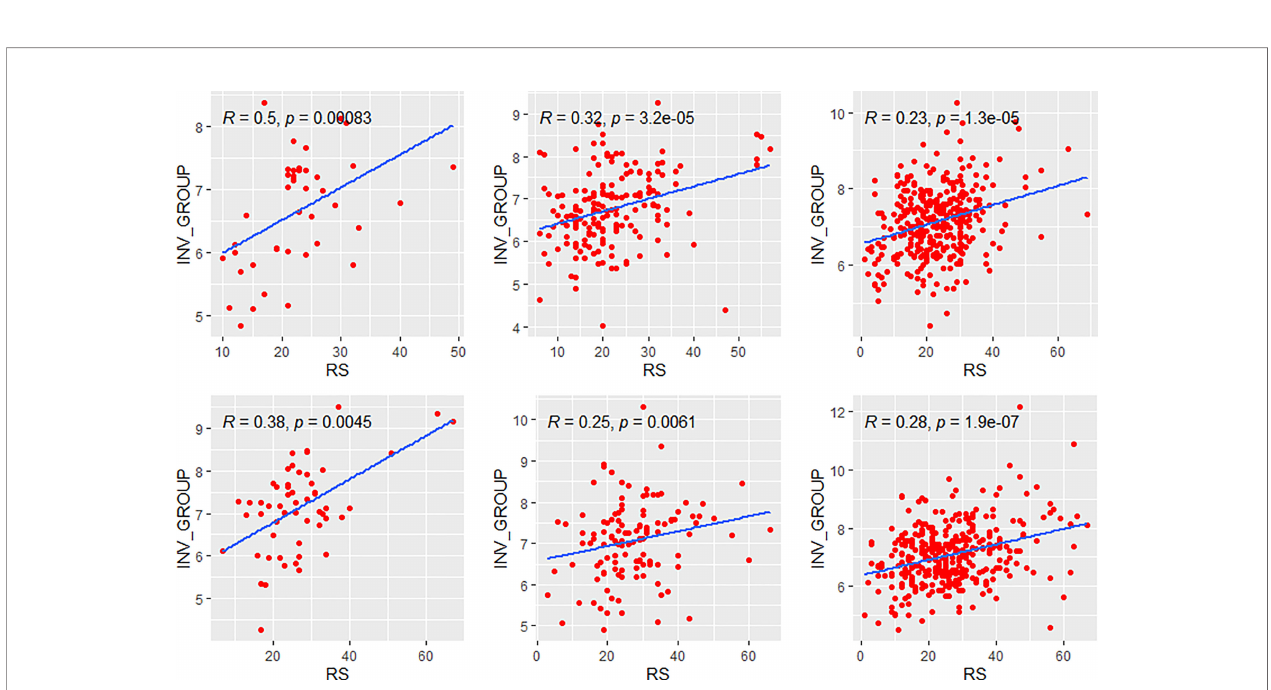
FIGURE 8 | Relationships of the RS with its invasion module. The upside and downside ranks showed the relationship in patients with low and high clinical risk respectively. Groups A, B, and C were presented from left to right. RS, recurrence score; INV, invasion.